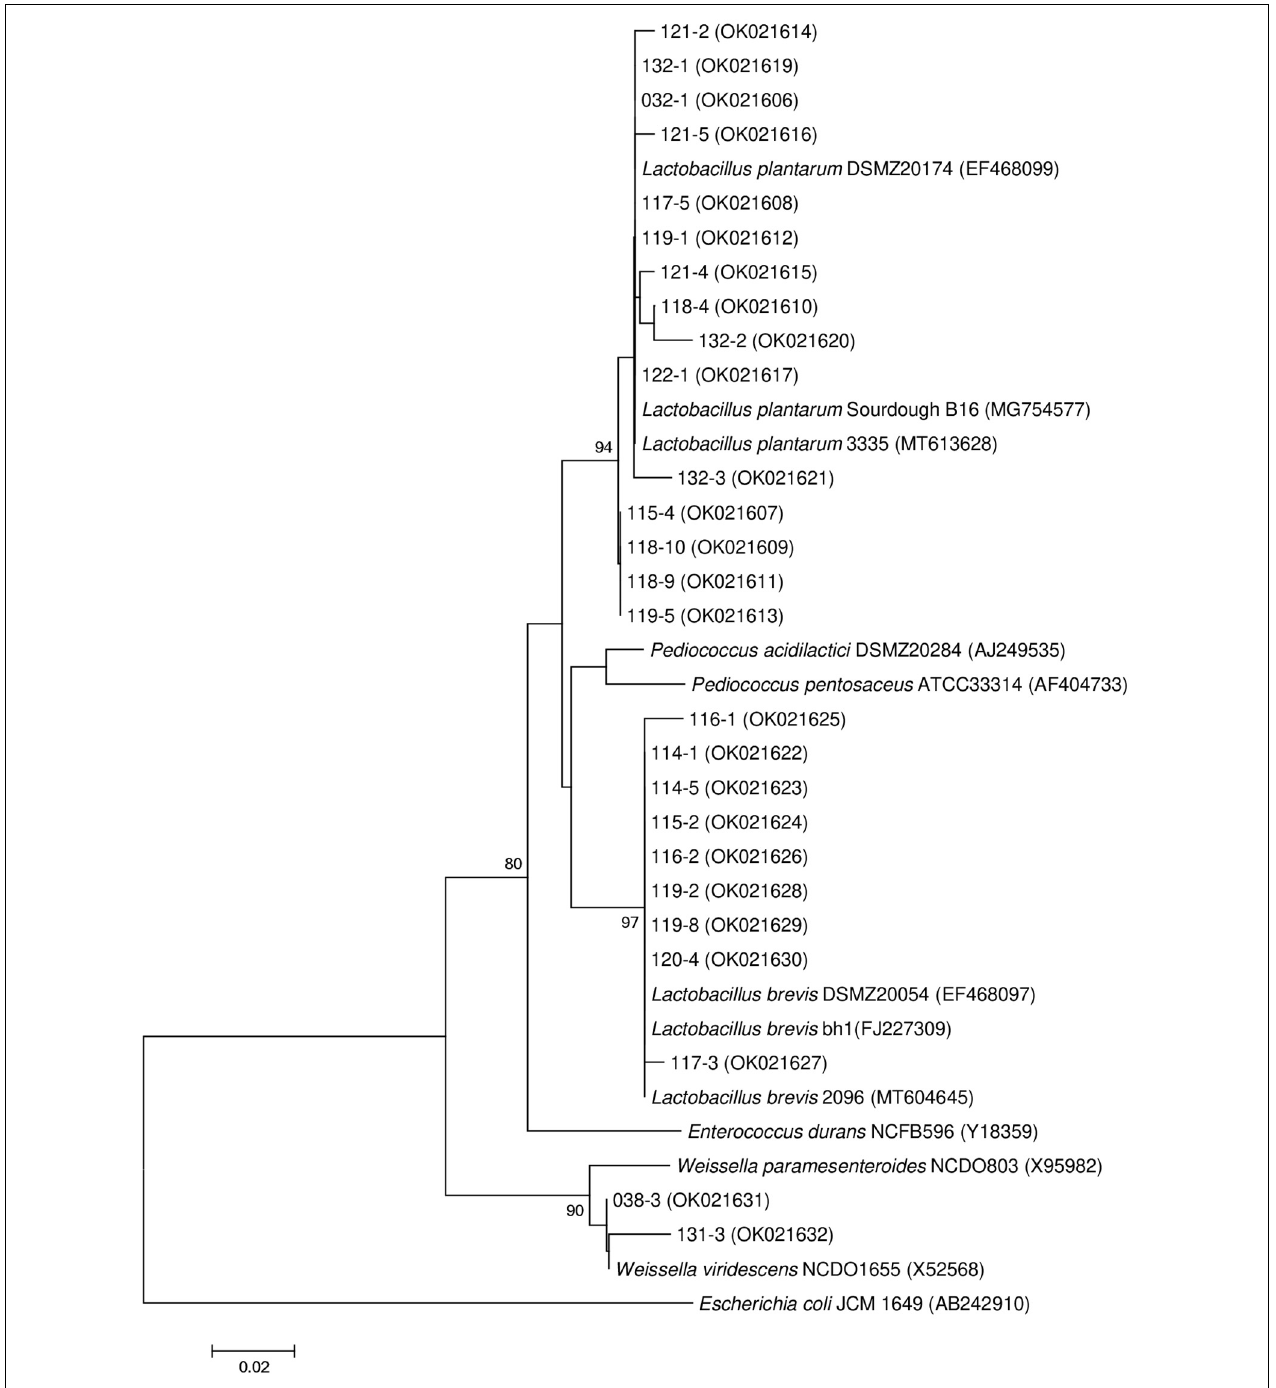
FIGURE 1 | Phylogenetic tree of lactic acid bacteria based on neighbor-joining distance analysis of 16S rRNA gene sequences.